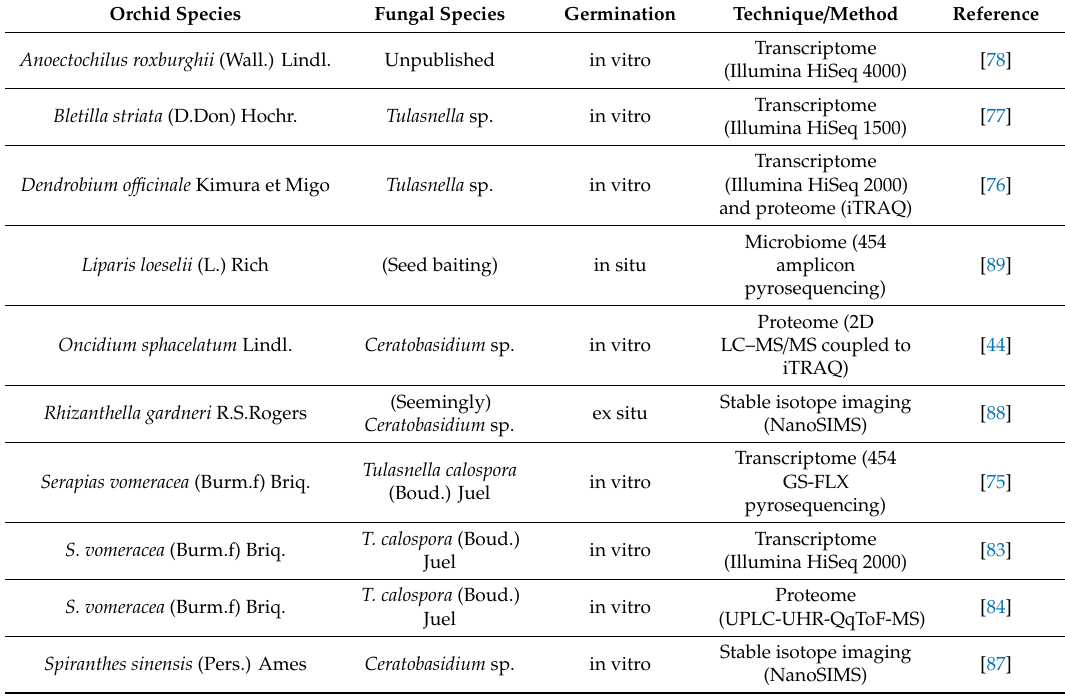
Table 2. Overview of current studies on orchid mycorrhizal symbiosis during the germination stage using “omics” and imaging